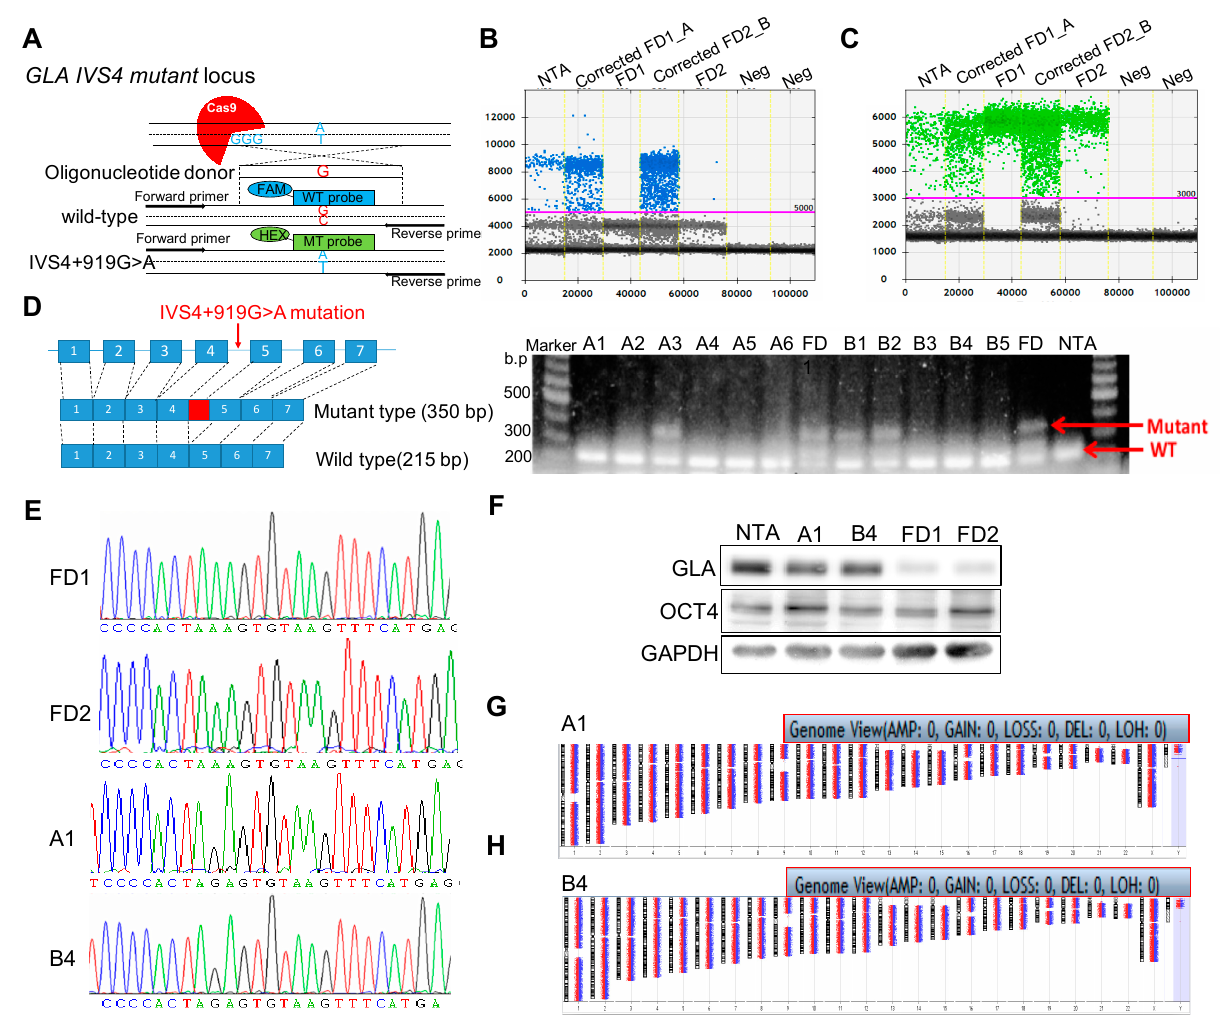
Figure 1. CRISPR/Cas9 corrected FD GLA IVS4 + 919G > A mutated induced pluripotent stem cells (iPSCs). ( A ) Schematic of guide RNA (gRNA) and donor template targeted region of the GLA locus of the patients with IVS4 + 919G > A mutation and probe design for homology-directed repair (HDR) genome-edited detection assay for droplet digital PCR (ddPCR)-based screening. Sensitive detection of GLA IVS4 + 919G > A mutant correction was performed using allelic discrimination edit detection assay by ( B ) 5-Carboxyfluorescein (FAM, blue) probe for Wild type (WT) allele and ( C ) Hex probe for mutant allele. ( D ) Reverse transcript PCR screening for GLA mutation of isolated clones after genetic correction by CRISPR/Cas9 and the single-stranded oligo donor (ssODN) template. ( E ) Sequencing results of selected corrected FABRY disease-iPSC (FD-iPSC) clones, A1 and B4. The light yellow box reveals mutant nucleotides substituted from A to G at IVS4 + 919 codon in FD-iPSCs. ( F ) The GLA protein levels of the corrected and uncorrected FD-iPSCs were evaluated with Western blot analysis. ( G , H ) Cytogenetic analyses of corrected FD-iPSCs, A1 and B4, demonstrated normal karyotypes individually. NTA is normal hiPSCs which served as control for normal GLA genome and pluripotency